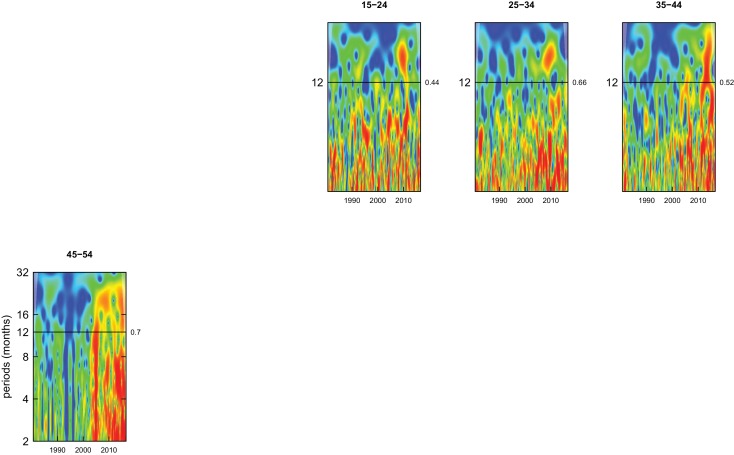
Wavelet power spectra for national time series of maternal condition death rates for 1980–2016, by age group for females.Wavelet power values increase from blue to red. The shaded regions at the left and right edge of each box indicate the cone of influence, where spectral analysis is less robust. P-values for the presence of 12 month seasonality are to the right of each figure at the 12 month line.